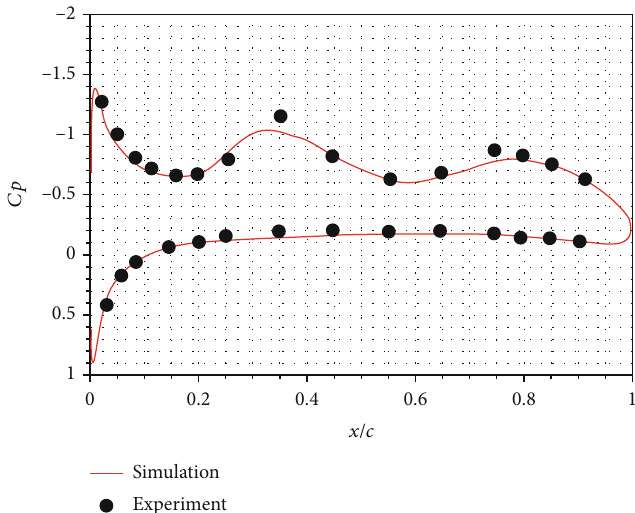
Figure 6: The pressure distribution at section z / c = − 2 : 25 % , case 2.